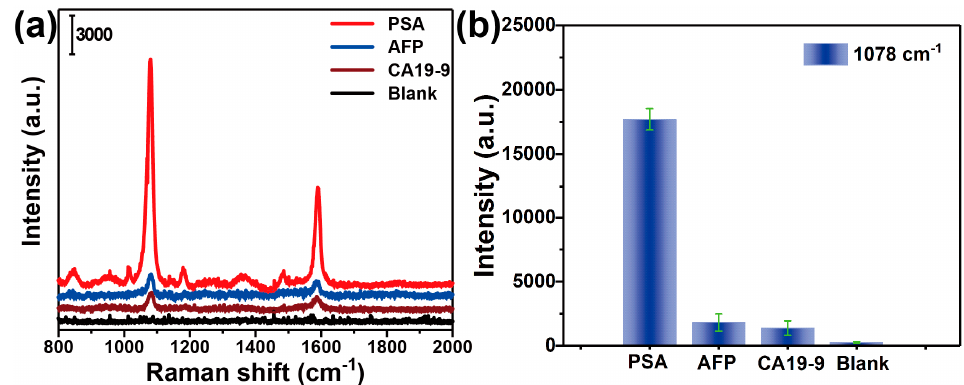
Figure 10. ( a ) SERS spectra of 4MBA in the specific immunoassay for PSA, AFP, and CA19-9, and the background signals without any target antigen; ( b ) Columnar distribution of the SERS peak intensity at 1078 cm − 1 .